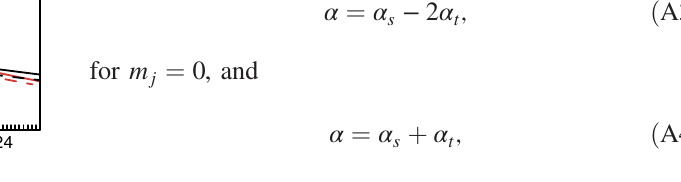
FIG. 6. Polarizabilities of the 5 s 2 1 S 0 and 5 s 5 p 3 P 1 states for Sr at linear trap polarization. Calculations with both ab initio (dashed lines) and recommended (solid lines) values predict the same magic wavelength at 520(2) nm for the 1 S 0 ↔ 3 P 1 j m j ¼ 0 i transition with α ¼ 880 ð 25 Þ a : u. Calculations with recom- mended values predict another magic wavelength at λ ¼ 500 . 65 ð 50 Þ nm for the 1 S ↔ 3 P 1 i transition with 0 1 j m j ¼ (cid:2) α ¼ 1230 ð 13 Þ a : u. We note that this latter crossing is valid even for elliptical trap polarizations, as it pertains to an excited sublevel with polarization-insensitive